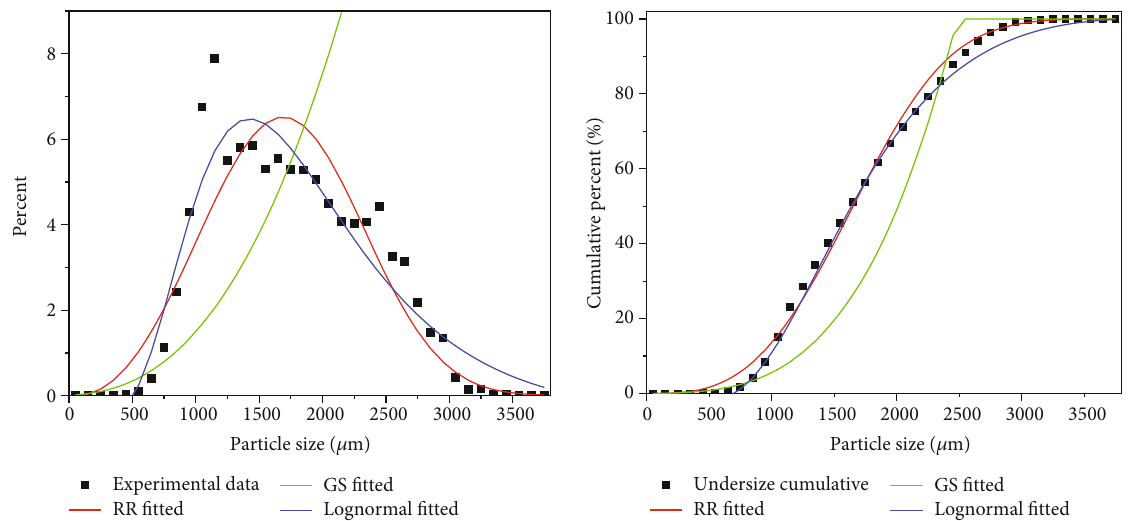
Figure 12: Comparison of di ff erent mathematical models of particle size distribution (RR, GS, and lognormal